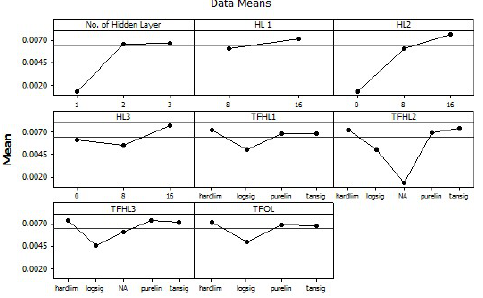
Fig. 11. Main Effects Plot for Training R